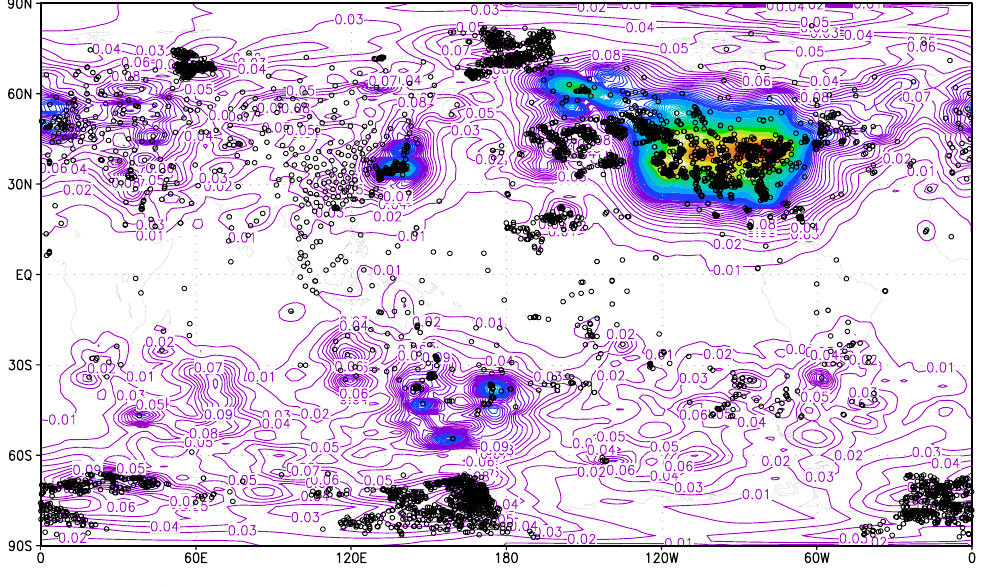
Fig. 10. The same as Fig. 9, but for u